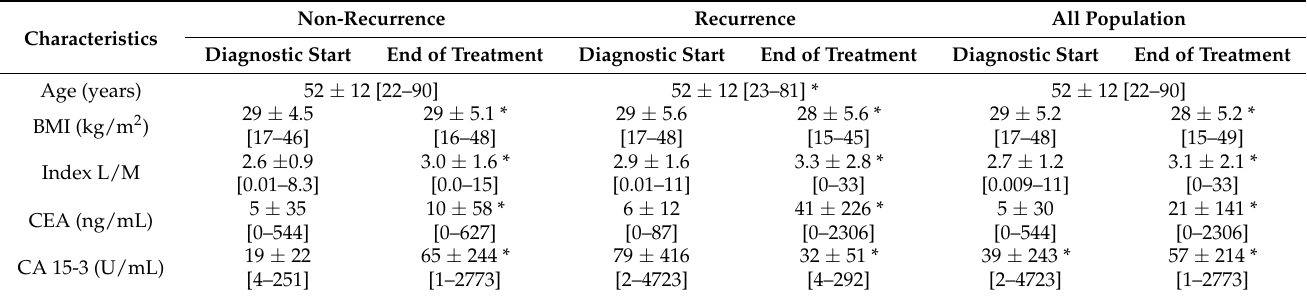
Table 2. Characteristics of Mexican women with breast cancer diagnostic and chemotherapy by treatment and end